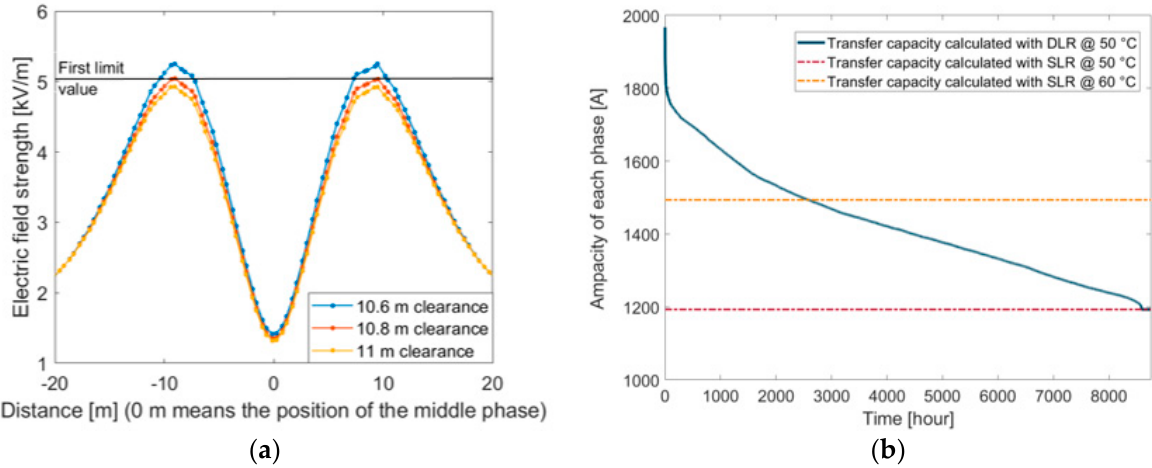
Figure 8. Results of the expert system. ( a ) Simulated electric field values in the critical span at different clearances; ( b ) transfer capacity 1-year duration curve calculated with DLR compared to ampacity calculated with SLR .